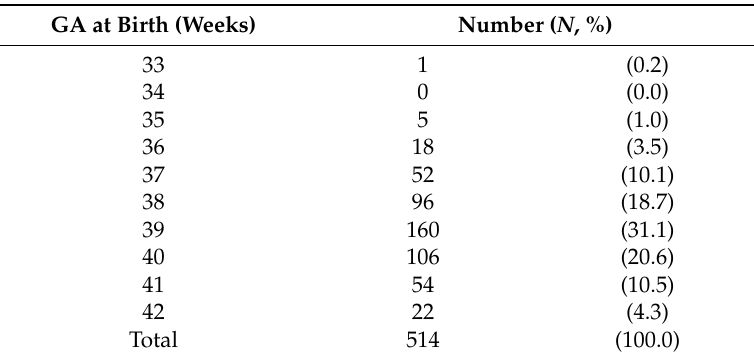
Table 2. The gestational age (GA) at birth of the study population.